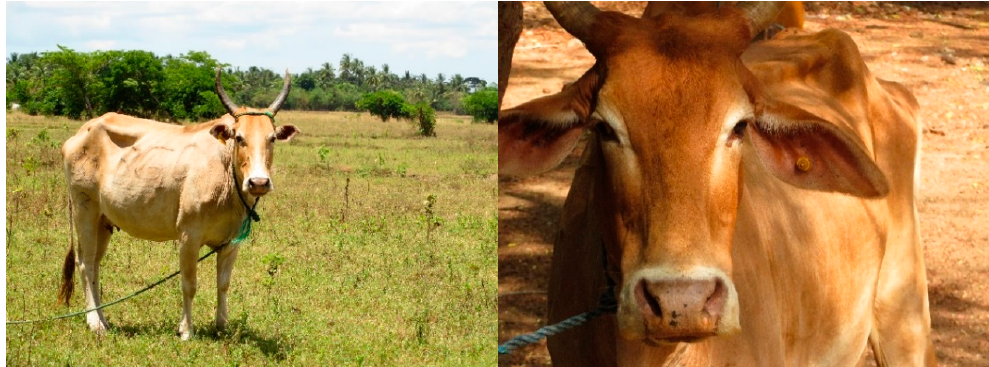
Figure 5. Farmers reported that efforts to introduce ear tags in the Eastern Province are impeded by poor tag retention in extensive